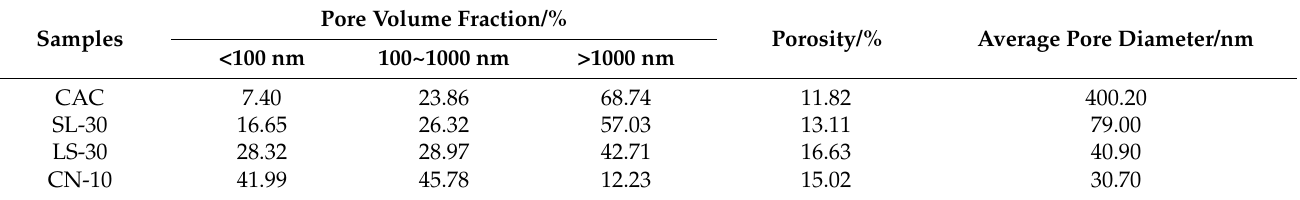
Figure 1. XRD pattern of CAC mortars (modified by mineral additions) cured at 40 ◦ C for 28 days. Table 6. Pore parameter of CAC mortars (modified by mineral additions) cured at 40 ◦ C for 28 d. Samples